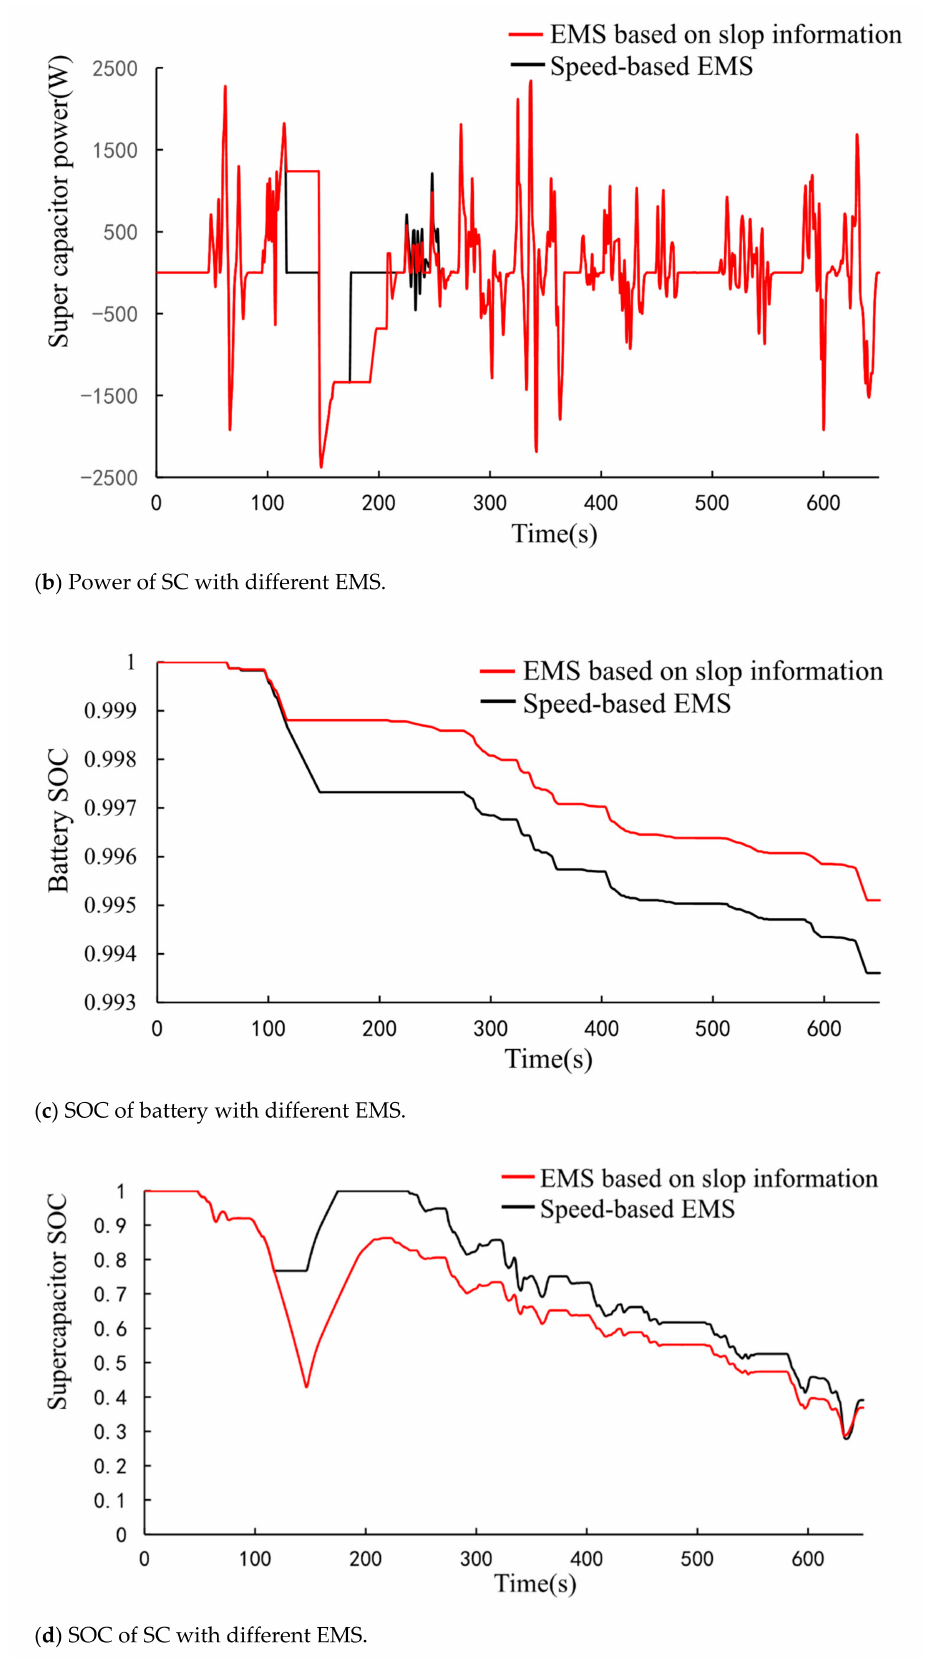
Figure 8. Simulation results under downhill